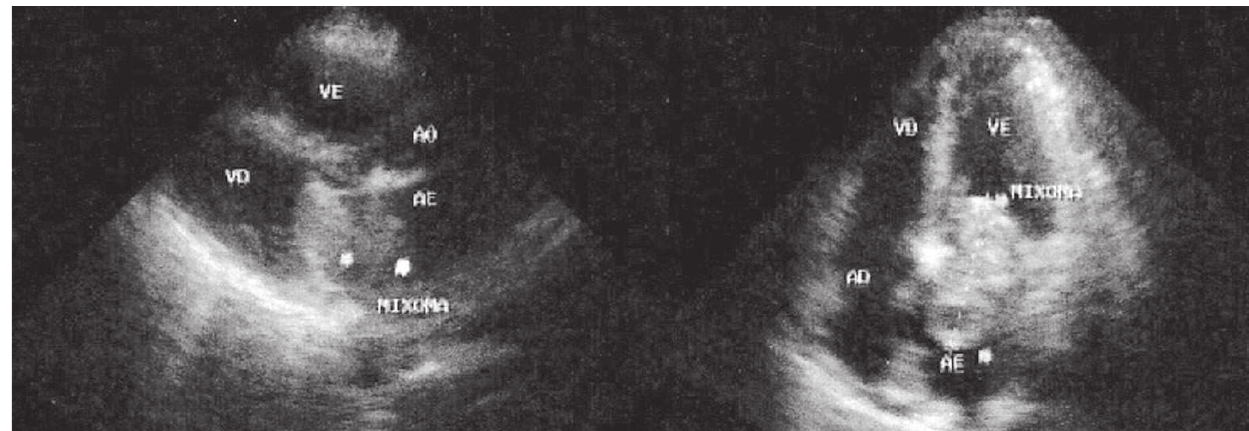
Fig. 1 - Ecocardiografia pré-operatória evidenciando presença de duas massas tumorais em átrio esquerdo (setas). AD: átrio direito; AE: átrio esquerdo; AO: aorta; VD: ventrículo direito; VE: ventrículo